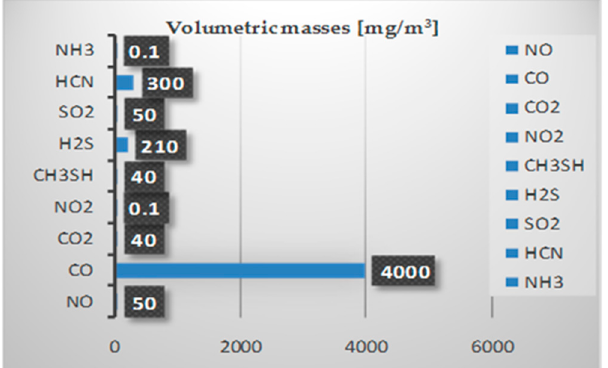
Figure 1. Percentage of substances with harmful